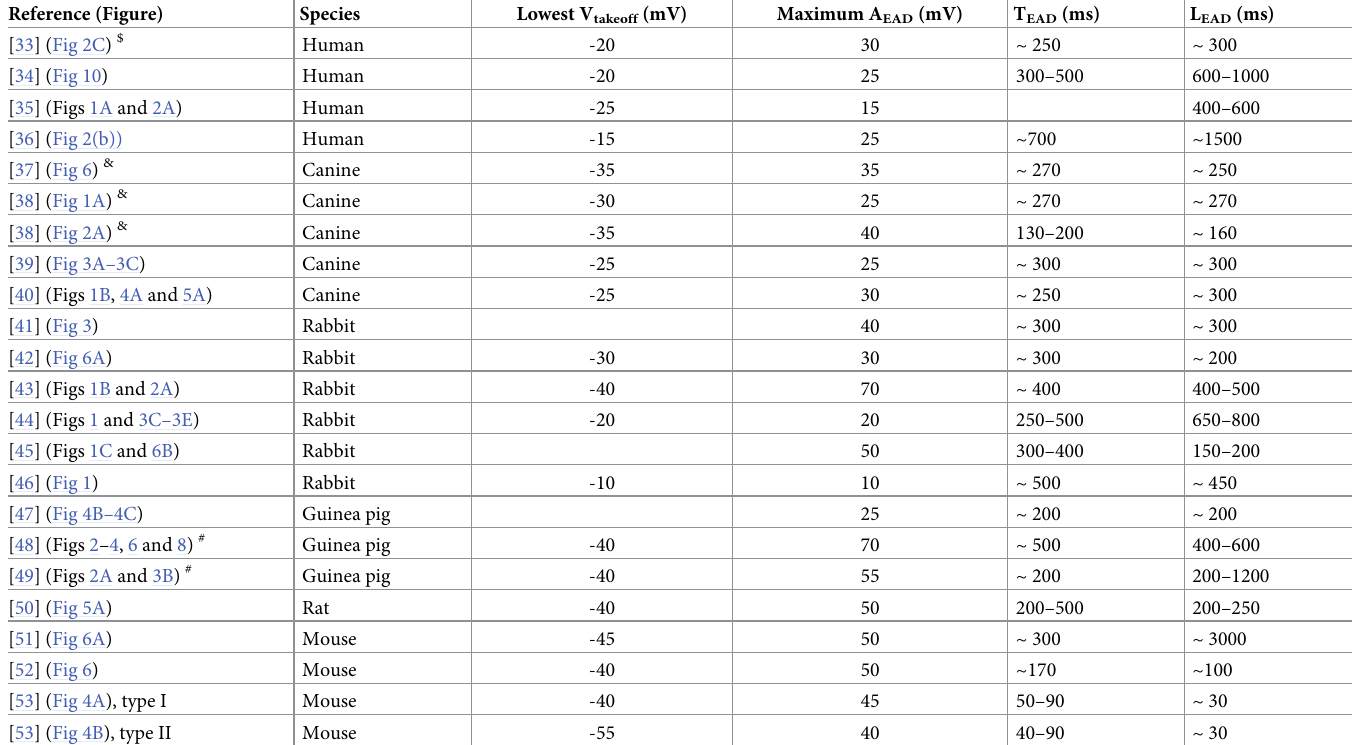
Table 1. Experimental EAD properties in isolated ventricular myocytes �